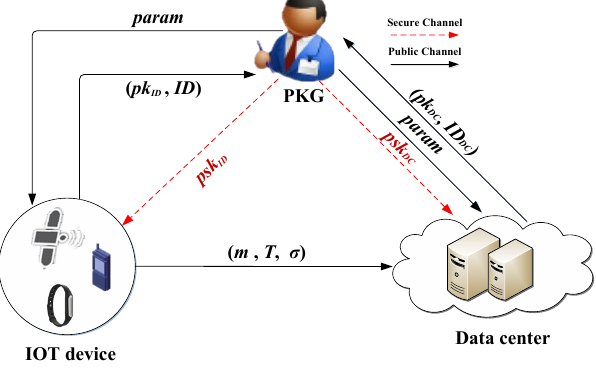
Figure 2. System model of the proposed certificateless signature (CLS) scheme for